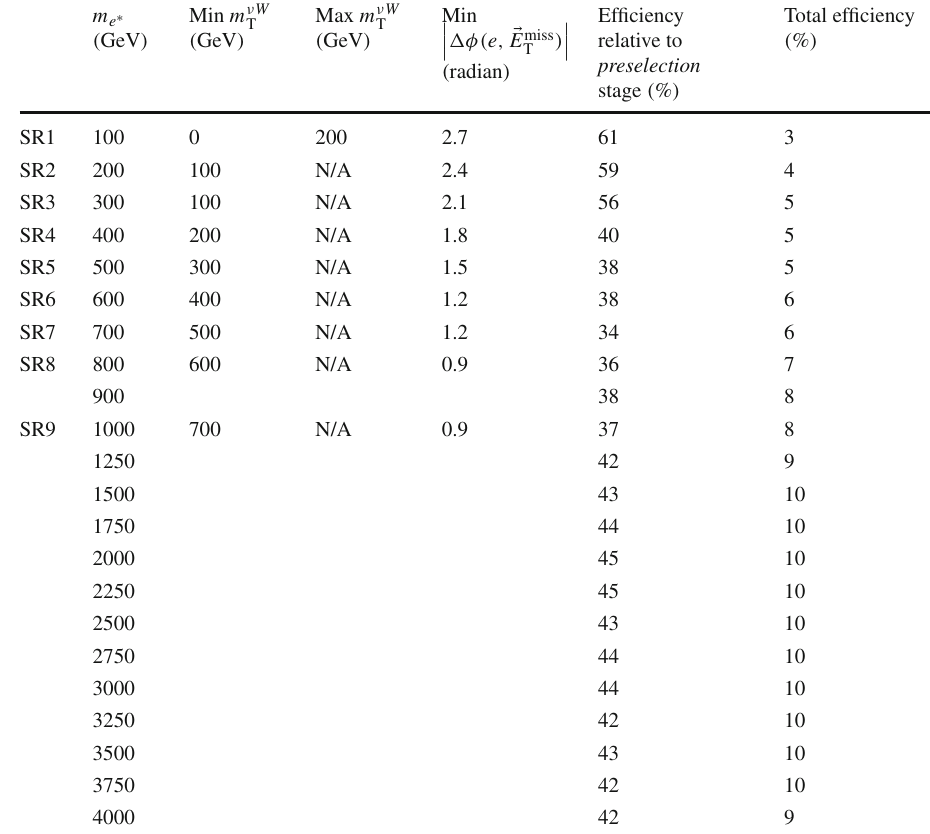
Table 5 Selection requirements for the SRs used to test various mass hypotheses in the e ν J channel. They are applied to discriminating variables after the preselection (Table 2) criteria. Signal efficiencies are presented as the number of signal events in each SR relative to that after the preselection and relative to that before any selection. Each signal region is valid for one or more mass hypotheses, as shown in the second column. “N/A” means the requirement is not applied for that